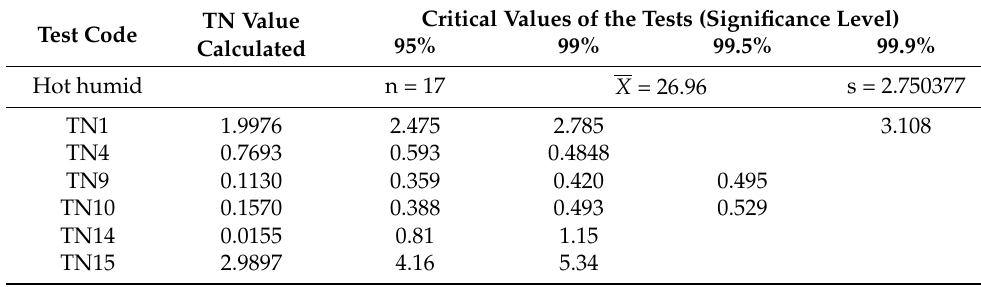
Table 6. Results of the discordance tests at equilibrium temperatures for a hot-humid climate.